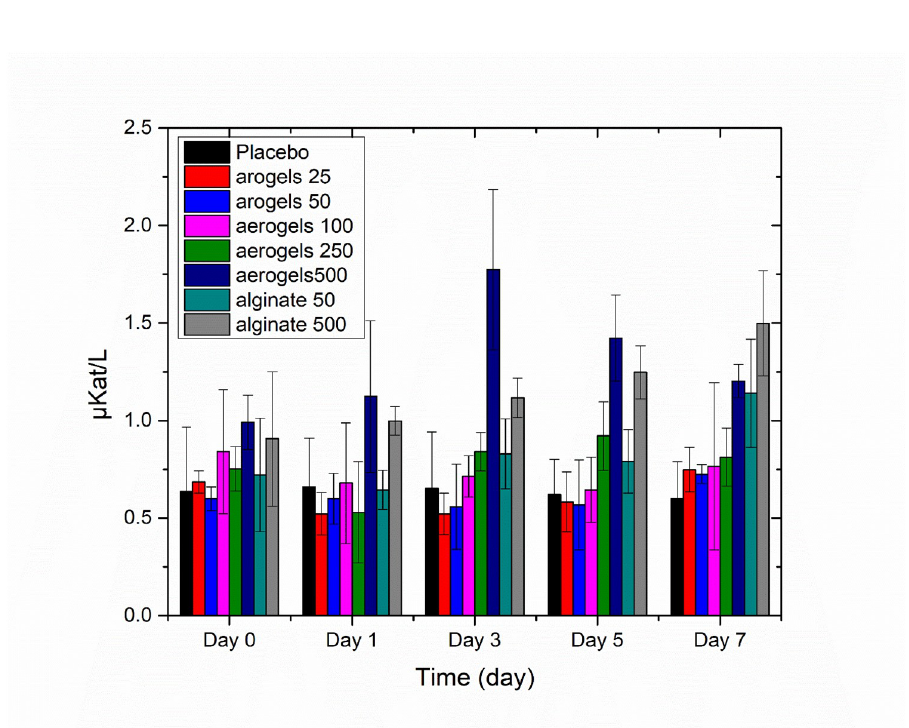
Fig 3. Short term analysis for the effect of different doses of calcium alginate aerogels and sodium alginate on ALP serum levels (aerogel corresponding to Ca-Alg aerogel and alginate corresponding to Na-Alg).